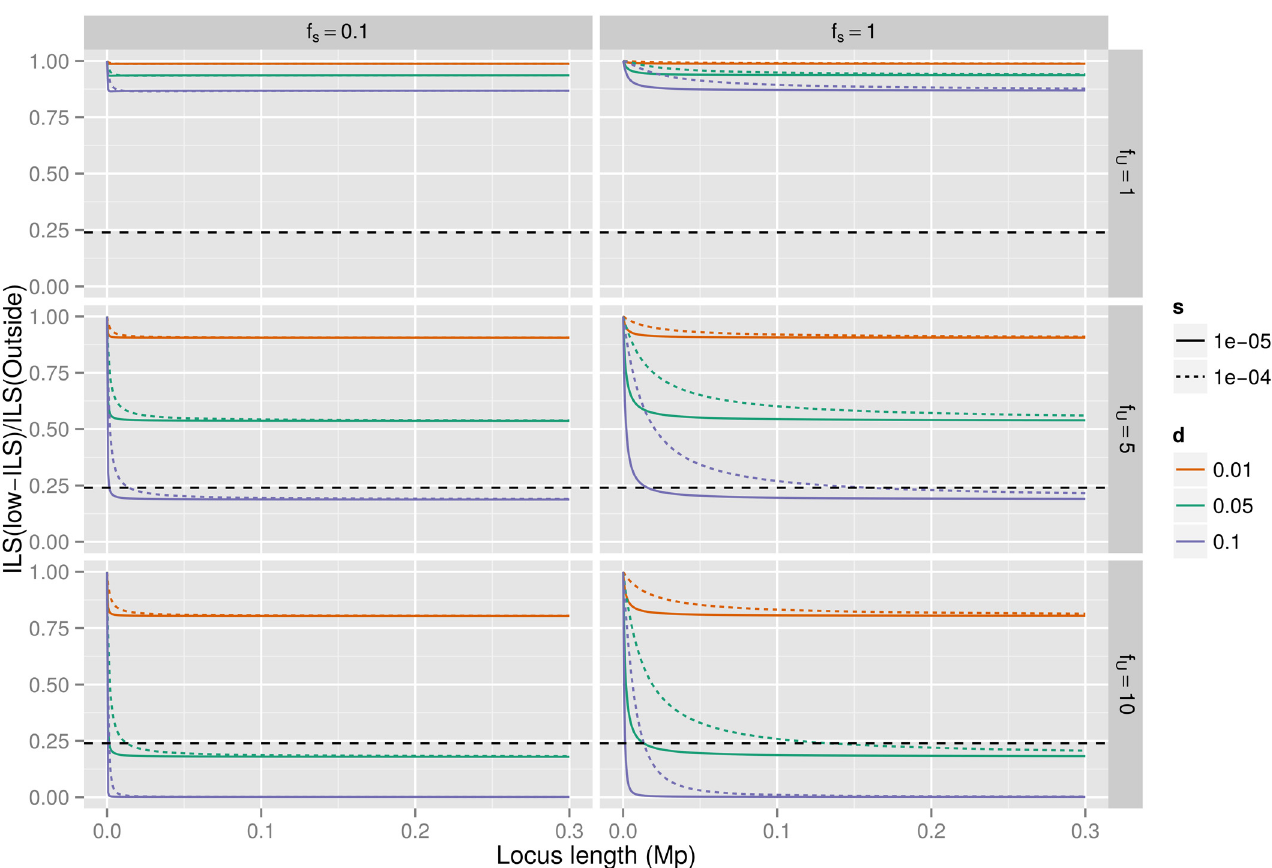
Fig 3. Background selection and ILS. The plots show the ratio of ILS inside the low ILS regions compared to that outside the regions, assuming speciation times of 5.95 mya and 3.7 mya, 20 year generations and that the neutral X effective population size is three quarters that of the autosomes. The colors correspond to different choices of which fraction of mutations are deleterious, varying from 1% to 10%. The different columns correspond to different choices of selection within the low ILS regions — set to either the same as outside or one tenth of the selection strength outside — and different rows show how much more of the regions is under selection compared to outside, either the same or a factor of five or ten. Selection strength is set to either 1e-4 (dotted curve) or 1e-5 (solid curve). The horizontal dashed line represents the observed reduction in ILS of 24% (from 21% ILS outside low-ILS regions to the < 5% ILS of low- ILS